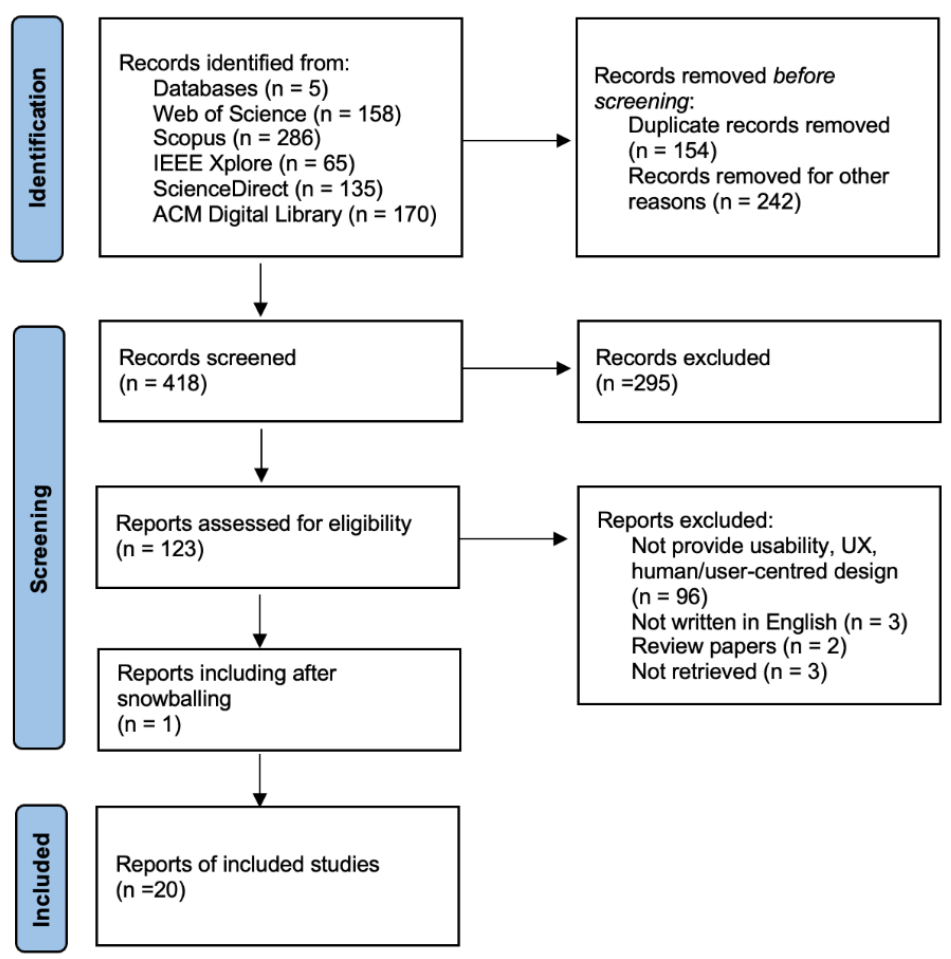
Figure 1. Number of papers included during the study selection process.